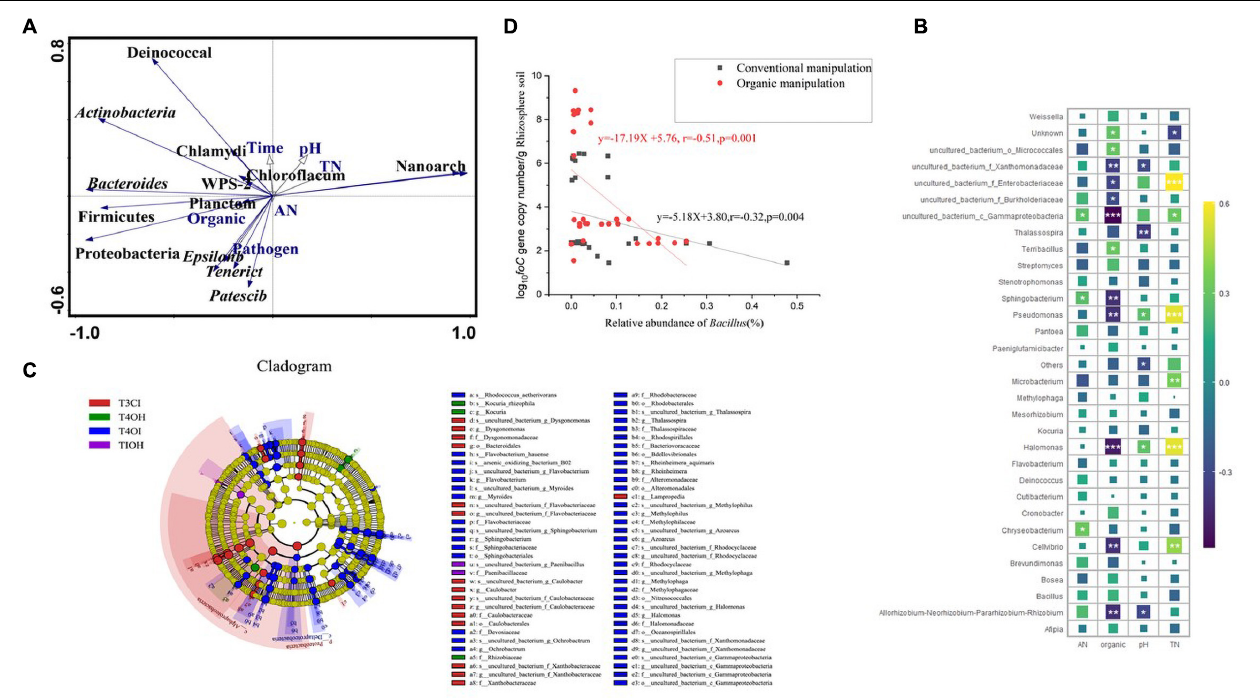
FIGURE 5 | (A) The relationship among the bacterial community, environmental parameters. Redundancy analyses (RDA) of the correlation between the bacterial community (Phylum level) and soil physicochemical properties. Gray lines represent significant factors and Blue lines represent key Phyla. (B) Correlation (Pearson’s coefficient) heat map between key rhizosphere soil bacterial community (genus level) and soil physicochemical properties of rhizosphere soil. *Denotes significance ( P < 0.05, FDR adjust), and ** denotes significance ( P < 0.01, FDR adjust). (C) Lefse analysis discrepancy in Endophytic bacterial taxonomy of Tomato between Healthy and Diseased Plants in the organic system greenhouse (LDA > 3.5, FD > 2, P < 0.05). (D) Correlation between log 10 foC gene copy number/g rhizosphere soil and relative abundance of Bacillus sp. in the organic greenhouse and conventional